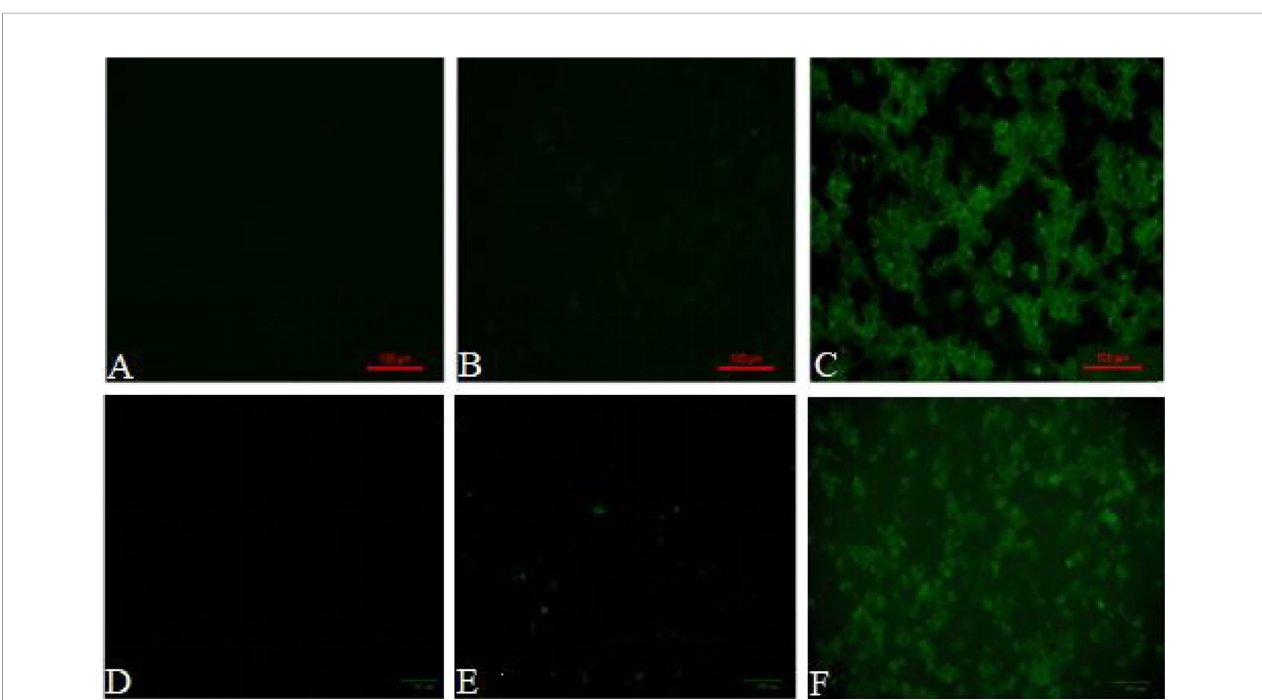
FIGURE 1 | EGFP expression in in RAW264.7 cells and peritoneal macrophages was examined by fl uorescence microscopy. Fluorescence microphotograph of (A) untreated RAW264.7 cells, (B) RAW264.7 cells incubated with pCI – EGFP (1 mg/mL), (C) RAW264.7 cells incubated with pCI – EGFP – loaded BGs, (D) untreated peritoneal macrophages, (E) peritoneal macrophages incubated with pCI – EGFP (1 mg/mL), and (F) peritoneal macrophages incubated with pCI – EGFP – loaded